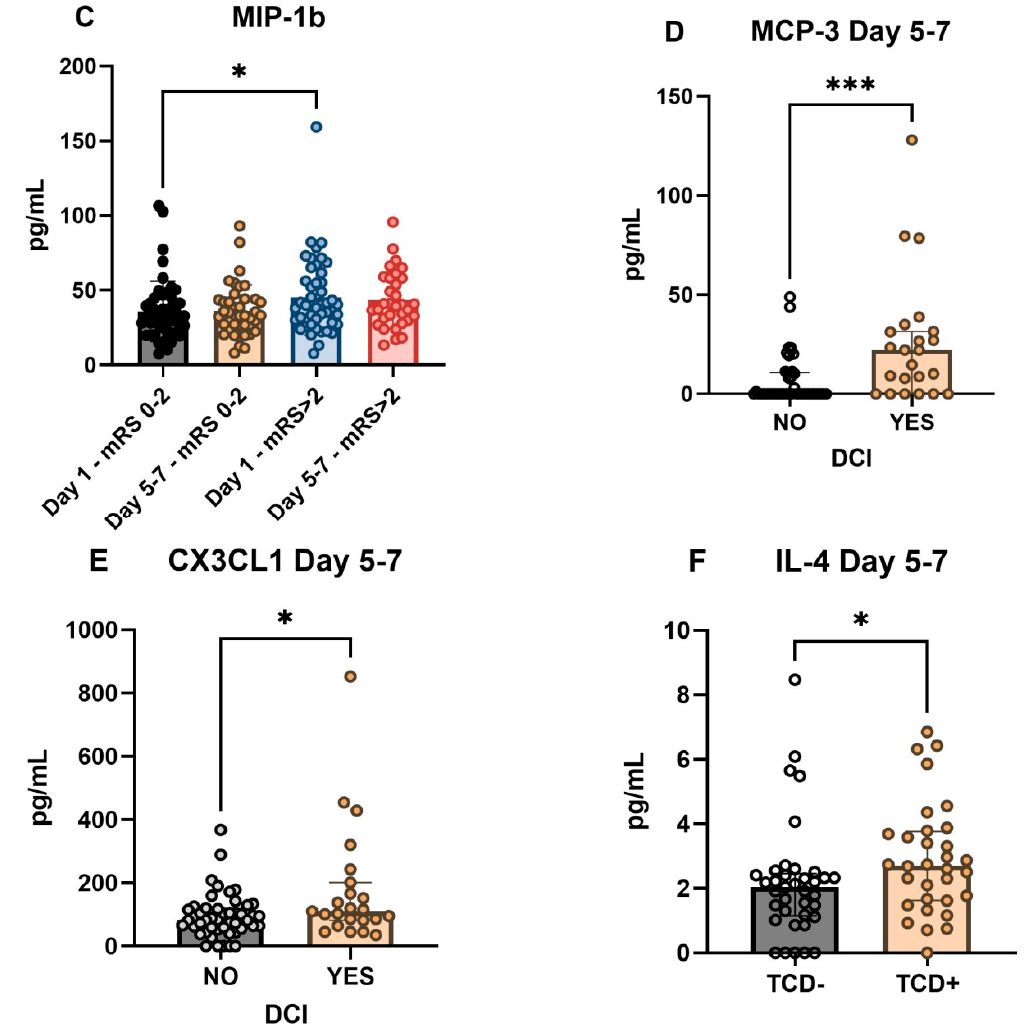
Figure 1. Characteristics of serum biomarker levels in different clinical subgroups in patients with aSAH. Correlation of the functional outcome with the investigated biomarkers, in the case of IP-10 ( A ), MCP-3 ( B ) and MIP-1b ( C ). Correlation of MCP-3 ( D ) and CX3CL1 ( E ) measured at T2 with DCI. Association of IL-4 ( F ) with TCD positivity. The functional outcome was examined 30 days after admission and characterized on the modified Rankin scale (mRS). Biomarker sampling times: Day 1, 24 h after aSAH, Day 5–7, 5–7 days after aSAH. DCI, delayed cerebral ischemia; aSAH, aneurysmal subarachnoid hemorrhage; TCD, transcranial Doppler ultrasound; CX3CL1, chemokine ligand 1, also known as fractalkine; IL-4, interleukin-4; IP-10, interferon gamma-induced protein 10, also known as C-X-C motif chemokine ligand 10 (CXCL10); MCP-3, Monocyte chemotactic protein-3; MIP-1b, macrophage inflammatory protein 1-beta. * denotes p < 0.05, *** denotes p < 0.001. In order to clarify how the increase of MCP-3 and CX3CL1 seen in DCI is related to the time of DCI, we performed an additional analysis. Average time of onset of DCI in our cohort was 6 ± 3.2 days (mean ± SD). We grouped the DCI cases based on the sampling dates: the cases before T2 were in group A, while the cases after T2 were in group B, Table